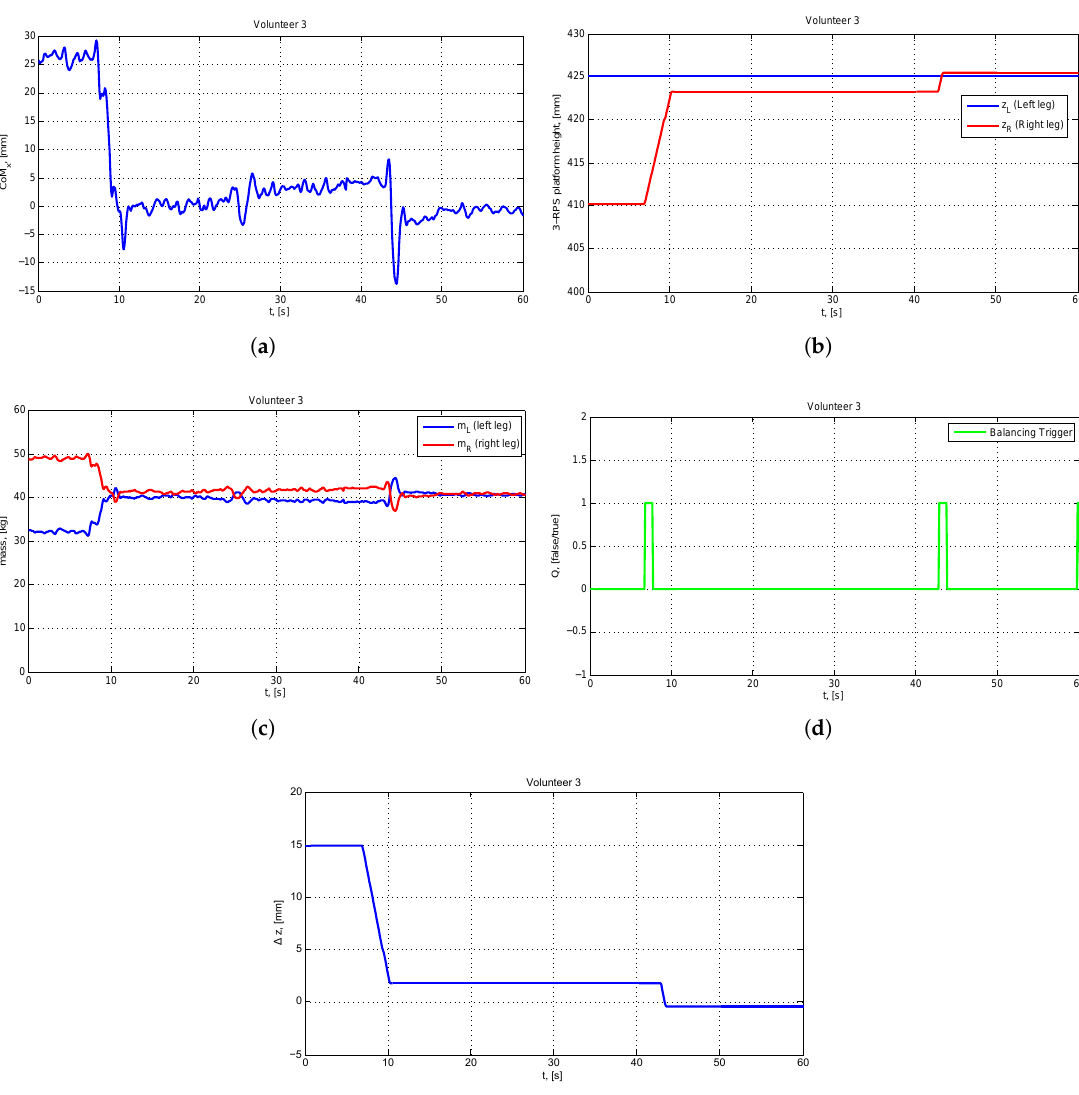
Figure 21. Experiment 3: ( a ) CoM x , the position of the human body’s CoM; ( b ) reference height of the left ( z Lref ) and right ( z Rref ) force plate, current height of the left ( z L ) and right ( z R ) force plate; ( c ) the load on the left ( m L ) and right ( m R ) leg; ( d ) the balancing trigger signal ( Q ) marking the start of a new HBBA iteration; and ( e ) left and right force plate height difference ( ∆ z ), which corresponds with the LLD evaluation ( ∆ l ) in the HBBA’s final